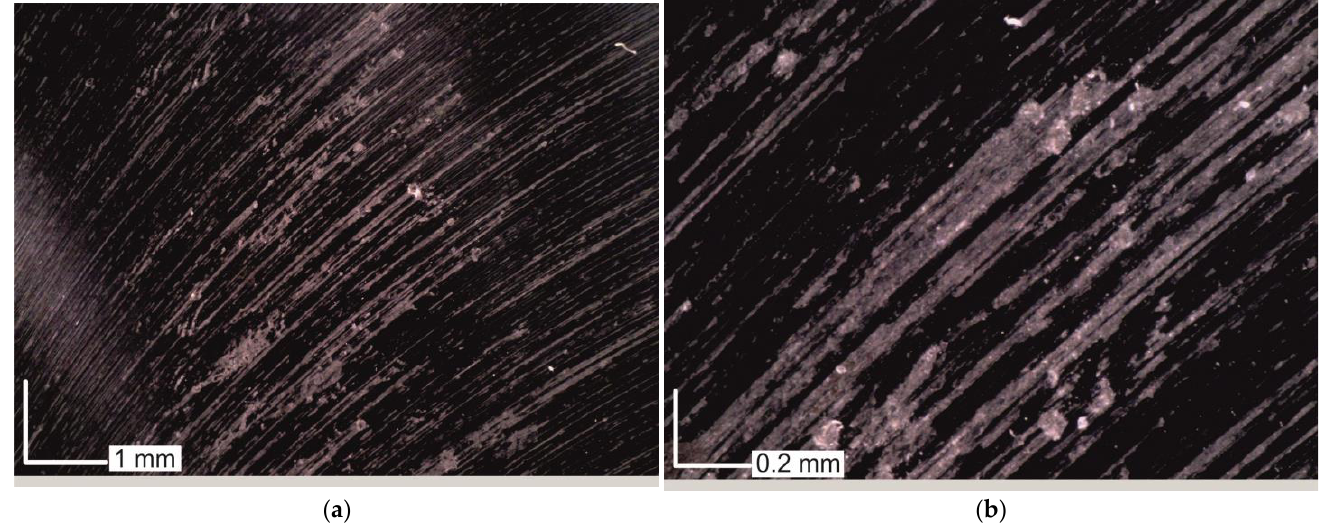
Figure 10. Surface after machining without cooling: ( a ) 100 times magnification; ( b ) 200 times magnification.